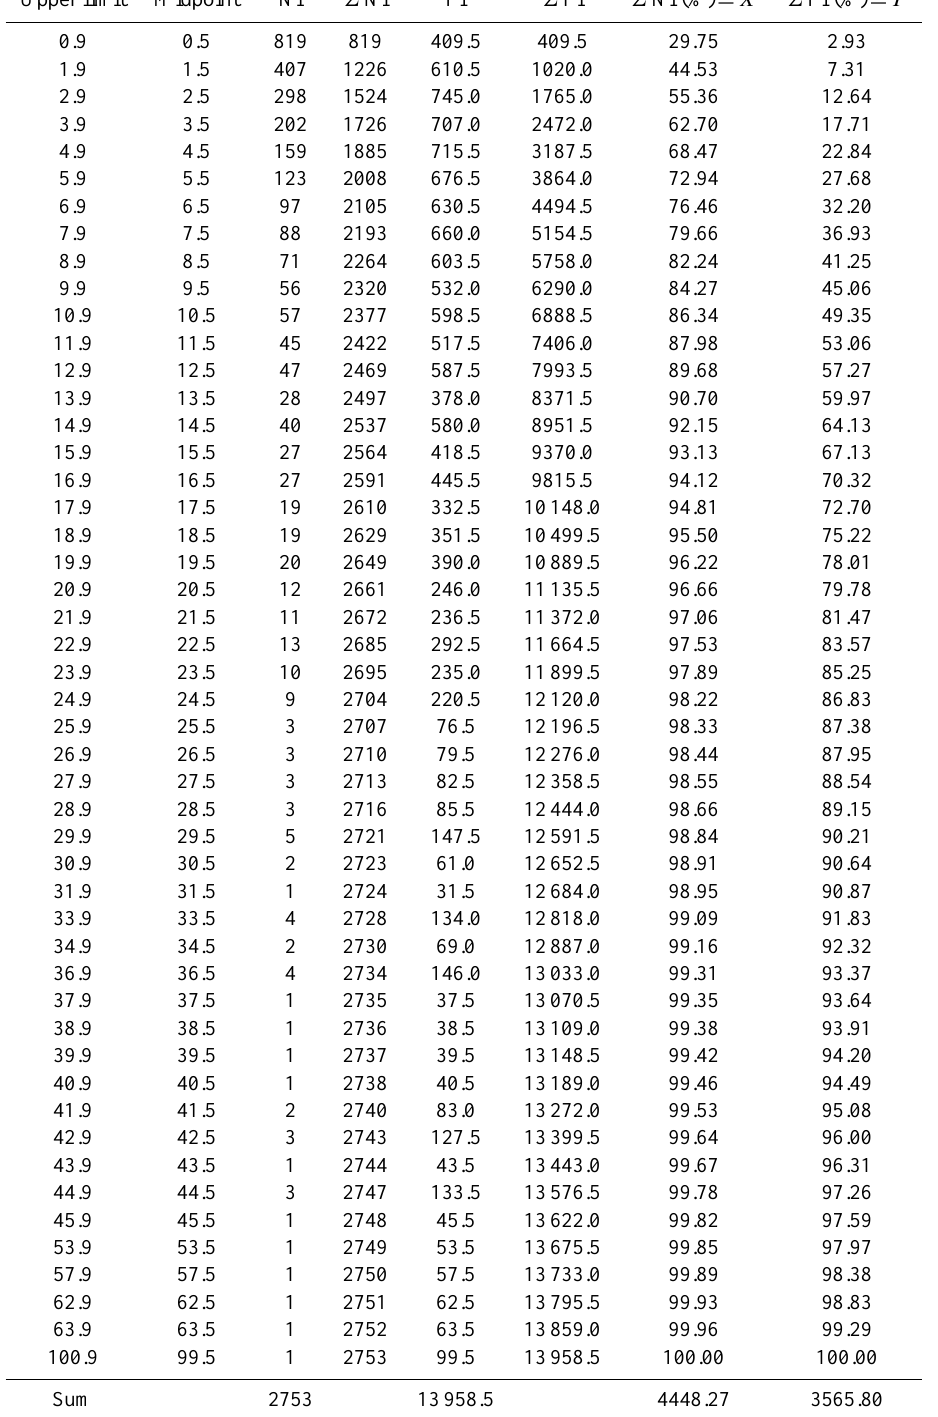
Table 1. Frequency distribution in classes of 1mm, relative cumulative frequencies ( X ) and corresponding percentages of the total precipi- tation ( Y ) in Chlef